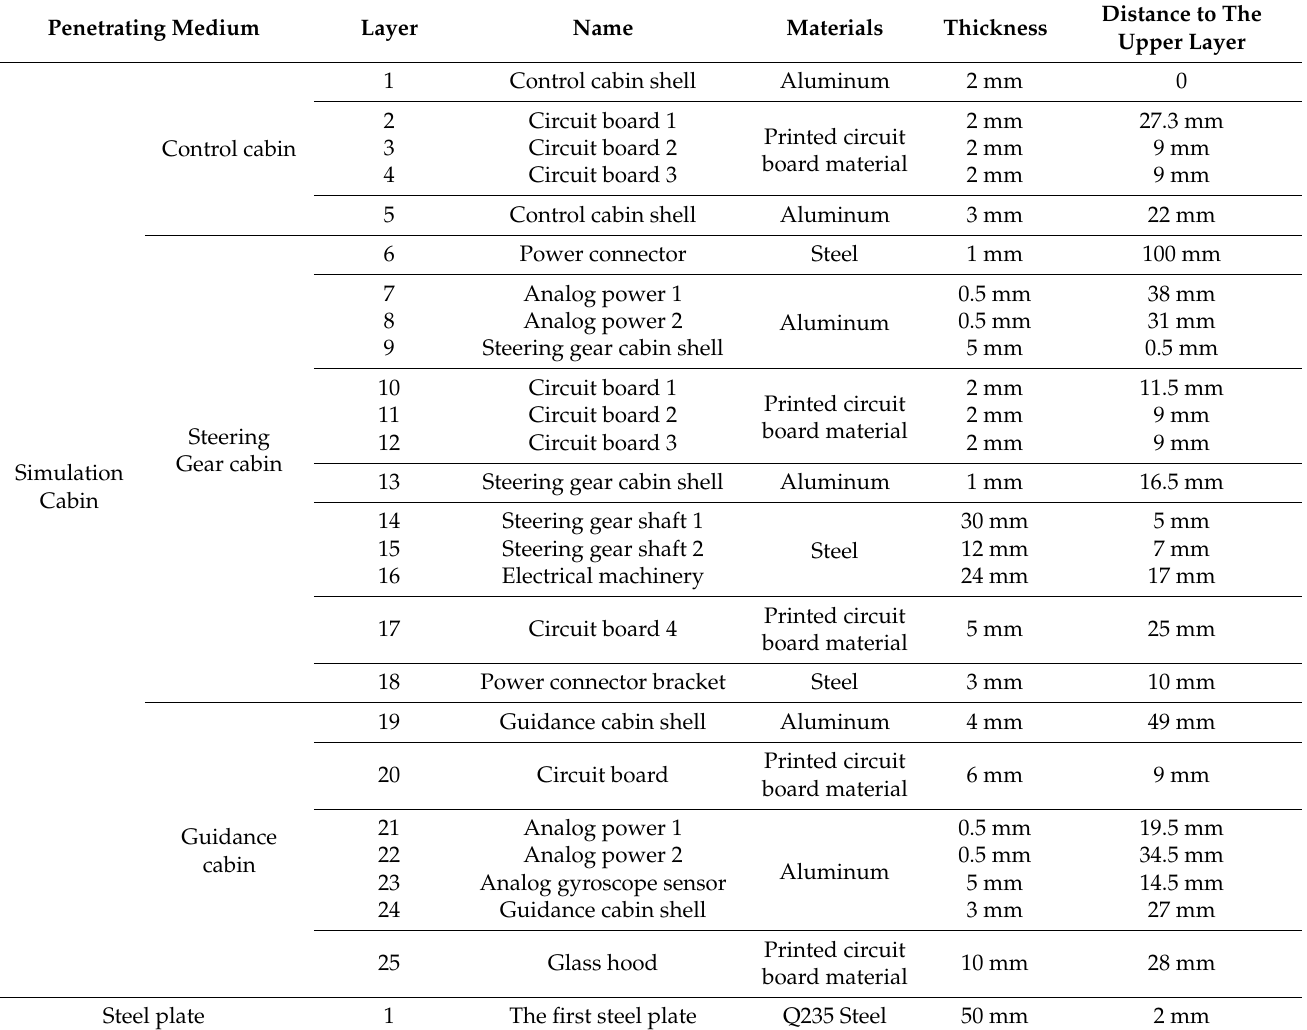
Table 1. Parameters of each layer